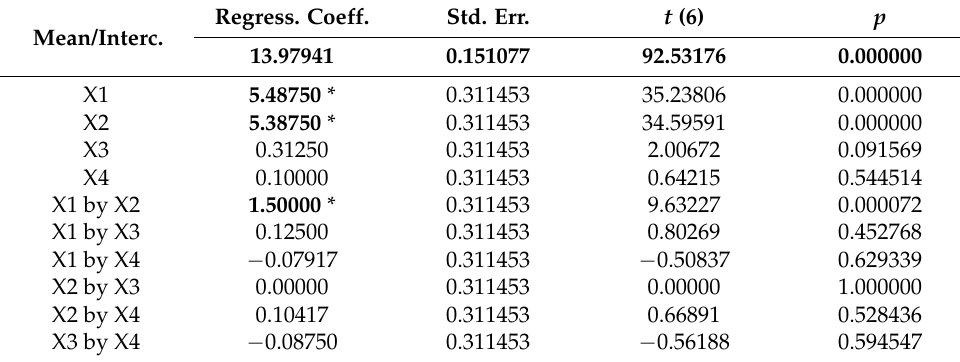
Table 4. Regression coefficients and t -test values.